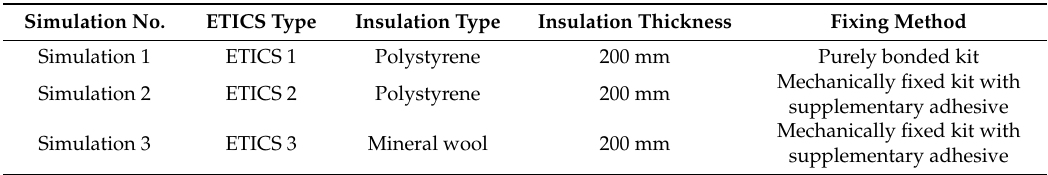
Table 1. Characteristics of the simulations.